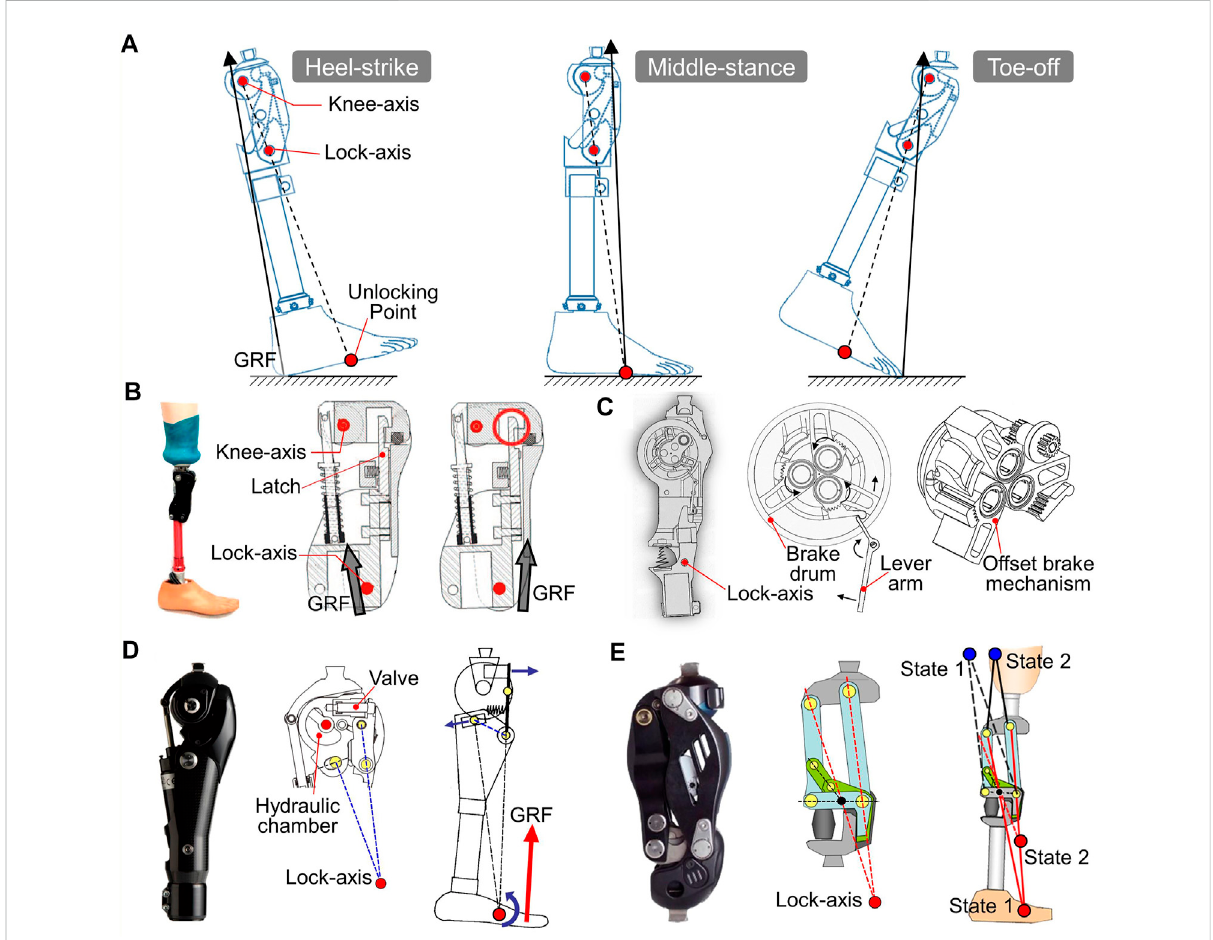
FIGURE 8 Prosthetic knees with both knee-axis and lock-axis mechanisms for stance stability. (A) Effects of lock-axis structure on joint at heel-contact, middle-stance, and toe-off (B) Knee with the latch mechanism (SASPL knee, Andrysek et al., 2011), reproduced with permission from copyright 2011 by SAGE. (C) Prosthetic knee with the offset brake mechanism (Boiten and Frick, 2017), reproduced with permission from copyright 2019 by Ottobock ® . (D) Knee with the virtual lock-axis based on crank-slider mechanism (Nabtesco ® Hybrid, Okuda et al., 2009), reproduced with permission from copyright 2009by Nabtesco ® . (E) Knee with thevirtual lock-axisbasedon six-barlinkagemechanism (Nabtesco ® NK-6 Symphony, Okuda and Nakaya, 2013), reproduced with permission from copyright 2013 by Nabtesco ®